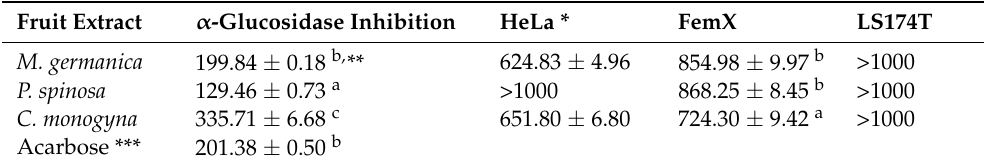
Table 4. The IC 50 values of the α -glucosidase inhibitory activity and cytotoxic activity of the fruit extracts.